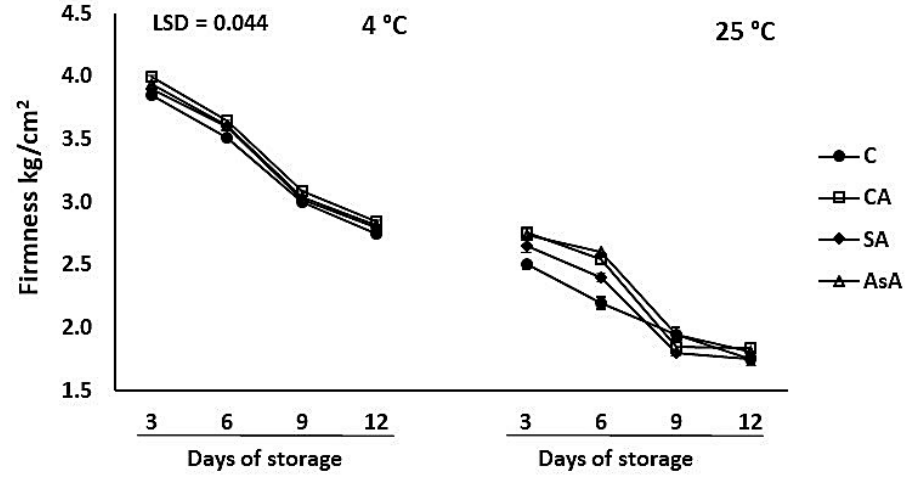
Figure 3. Effects of bio-stimulants B, control (C), citric acid (CA), salicylic acid (SA) and ascorbic acid (AsA), storage period SP (3, 6, 9 and 12 days) and storage temperature T (4 °C and 25 °C) on firmness of okra pods. Error bars are the ±SD of the means of three biological replicates for each temperature condition. LSD values ( p ≤ 0.05) for B = 0.02, SP = 0.02, T = 0.01, B × SP = 0.03, B × T = 0.02 and SP × T = 0.02. LSD for B × SP × T is presented on the figure.